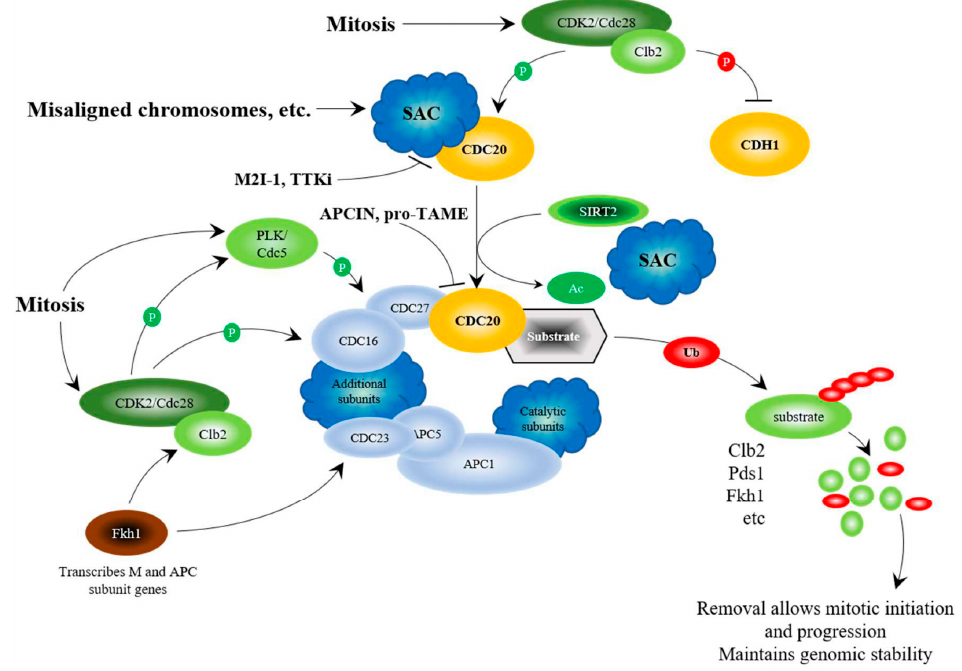
Figure 1. Regulation of the APC at the G2/M transition. The schematic considers results from mammalian and yeast studies. Yeast proteins are written as Cdc20, whereas mammalian proteins are written as CDC20. Genomic stability and segregation of replicated and repaired chromosomes is established via the Spindle Assembly Checkpoint (SAC) that sequesters Cdc20/CDC20 away from the APC, thus inhibiting APC function as cells enter mitosis [77,78]. When the SAC is satisfied, the cyclin Clb2 (Cyclin B), synthesized during G2 by Fkh1 [79], interacts with cyclin-dependent kinase Cdc28 (CDK2) to phosphorylate a series of proteins needed for mitotic progression: Cdc5 (PLK), Cdc16, Cdc23, and Cdc27 [80,81]. Once PLK is active, it further activates the APC by phosphorylating Apc9 (or APC1 in mammalian cells), Cdc16 and Cdc27 [80,81]. Cdc28-Clb2 also phosphorylates the co-activators Cdc20 for activation [80], and Cdh1 for inhibition [82]. A further activating stimulus is provided by SIRT2, which deacetylates CDC20 [83]. APC Cdc20 then targets proteins for degradation, such as Pds1 (PTTG1/Securin), to allow chromosome segregation, and Clb2 and Fkh1 to complete a negative feedback loop that prepares the cell for mitotic exit and G1 maintenance [65,84,85]. Degradation of Clb2 stops inhibition of Cdh1, allowing replacement of the APC Cdc20 complex with APC Cdh1 . APC chemical inhibitors, APCIN and pro-TAME, disrupt the CDC20-APC interaction